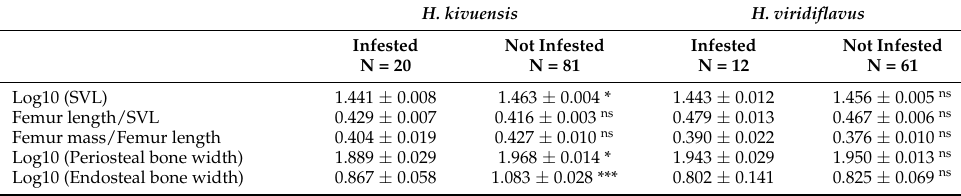
Table 5. Sublethal impact of Clinostomum chabaudi metacercariae on size and femur features of reed frogs in Rwanda. Data are given as least square mean ± SE, calculated in an ANCOVA with infestation state as fixed factor, and age and day within the rainy season as continuous covariables. Significance of pairwise comparisons: ns = P > 0.05, * = P < 0.05, ** = P < 0.01, *** = P <